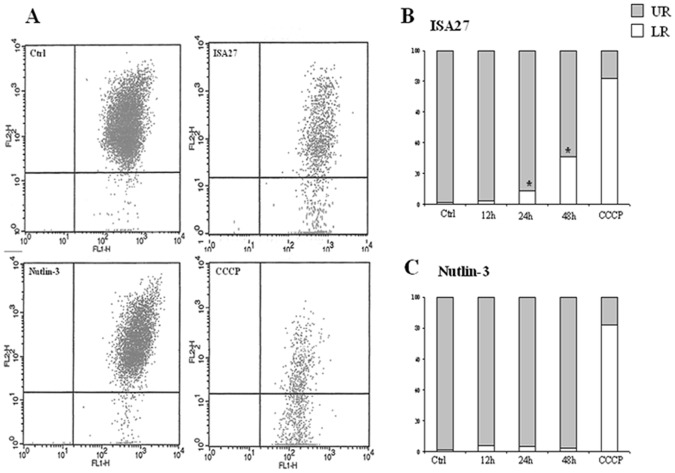
ISA27 induces the dissipation of the mitochondrial membrane potential.
10A) Representative dot plots of untreated and MDM2 inhibitor-treated cells: After ISA27 treatment, mitochondrial depolarisation is visible by a decrease and an increase in fluorescence in the FL-2 and FL-1 channels, respectively. After Nutlin-3 treatment, mitochondrial depolarisation is not visible; CCCP is the positive control. 10B and C) Time-course analysis of ΔΨm dissipation: Histograms show the mean values of cell percentages either in the UR (polarised mitochondria) or LR (depolarised mitochondria) quadrant of the ΔΨm analysis plots derived from three independent experiments.